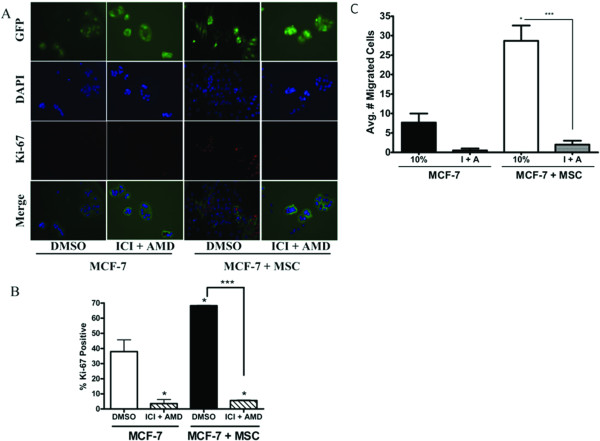
Co-inhibition of ER and CXCR4 signaling decreases hMSC stimulated MCF-7 proliferation and migration in vitro. MCF-7-GFP cells cultured with or without hMSCs were treated with DMSO (control) or ICI (100 nM) + AMD3100 (5 μg/ml) for 72 hours. Cells were fixed and stained with anti-Ki-67 (red) and nuclei were counter stained with DAPI (blue). (A) Representative images of MCF-7 cells cultured alone (left) or with hMSCs (right) at 200×. (B) Quantification of GFP cells positive for Ki-67 staining from 10 fields of view per treatment. Data is represented as percent positive MCF-7 cells as compared to total number of MCF-7 cells counted. Bars represent mean values ± SEM. (C) MCF-7 cells alone or in combination with hMSCs (1:1 mix) were seeded in the upper chamber of a transwell system where the lower wells contained culture media supplemented with 10% FBS (10%). Upper and lower chambers were treated with either DMSO (control) or ICI (100 nM) + AMD3100 (5 μg/ml). After 48 hours cells were fixed and the number of migrated cells counted. Bars represent average number of migrated cell per condition ± SEM, (*, p < 0.05; ***, p < 0.001).